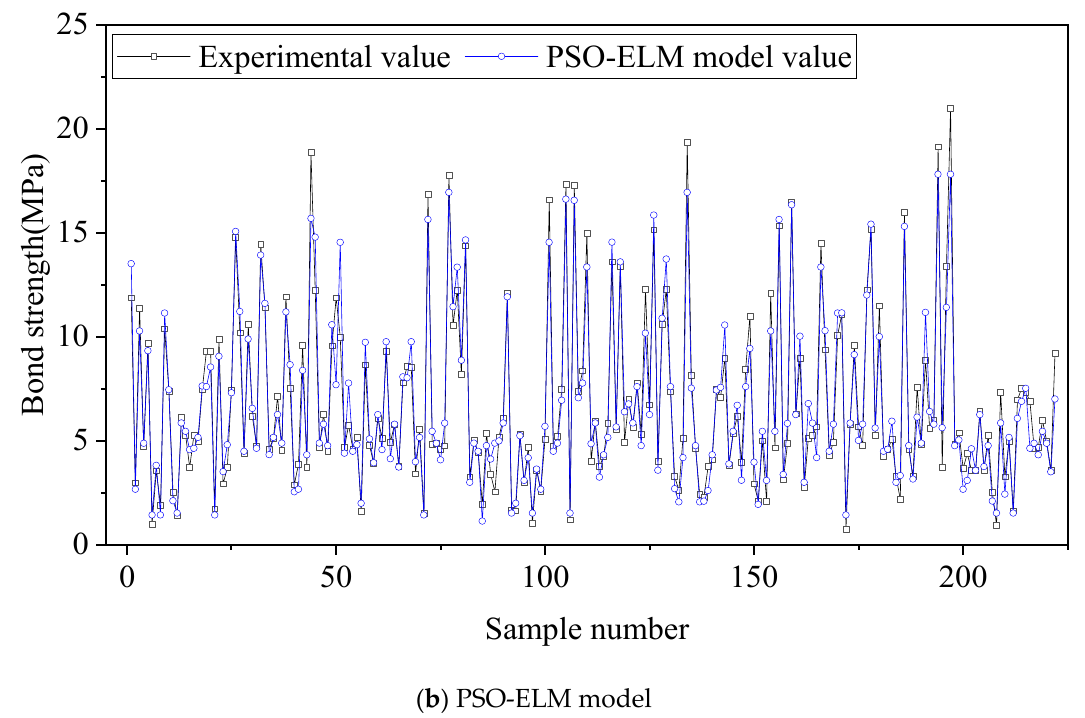
Figure 4. Comparison between predicted bond strength and the actual values of two models.